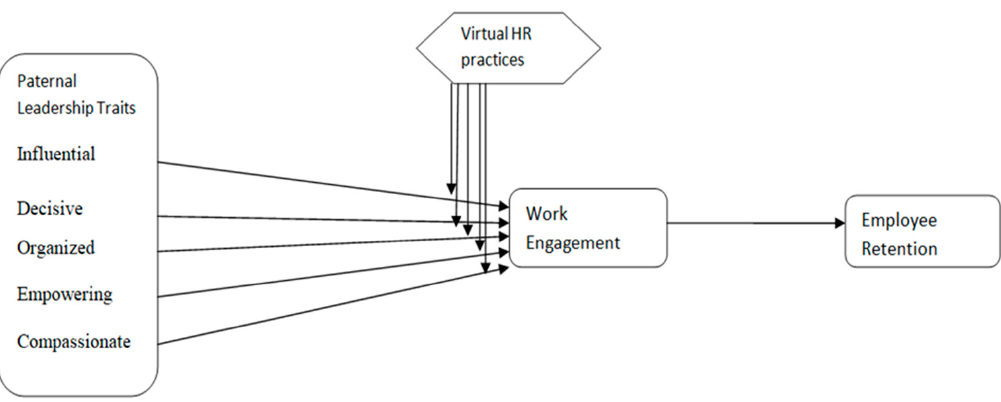
Figure 1. Theoretical Model.